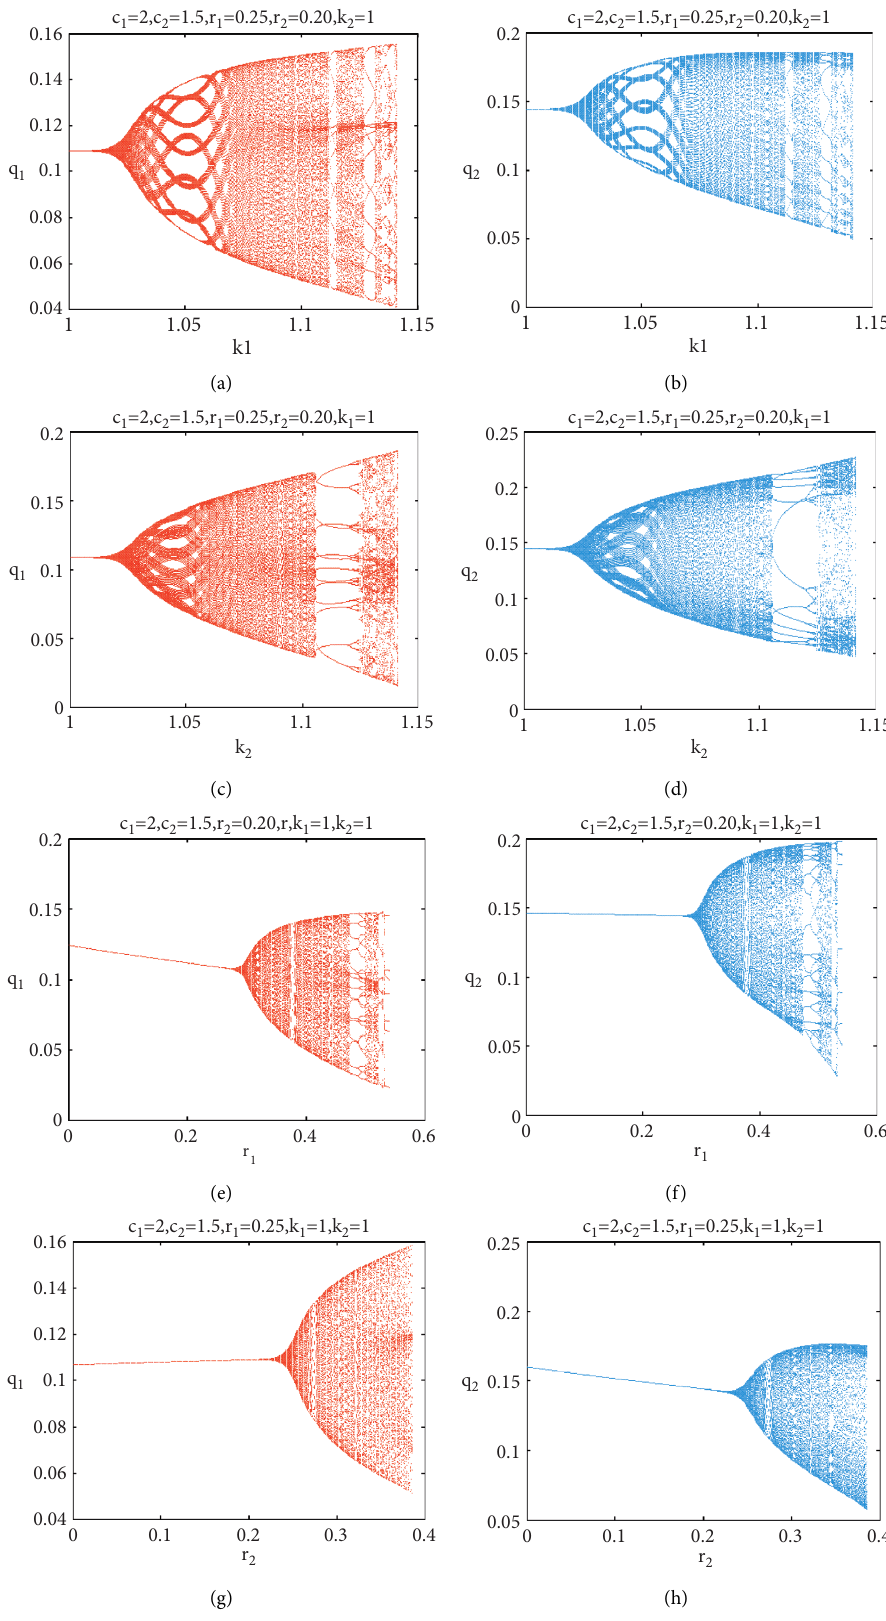
Figure 2: (a–h) The N-S bifurcation diagrams with respect to the parameters r parameters values given in the text and within the figure